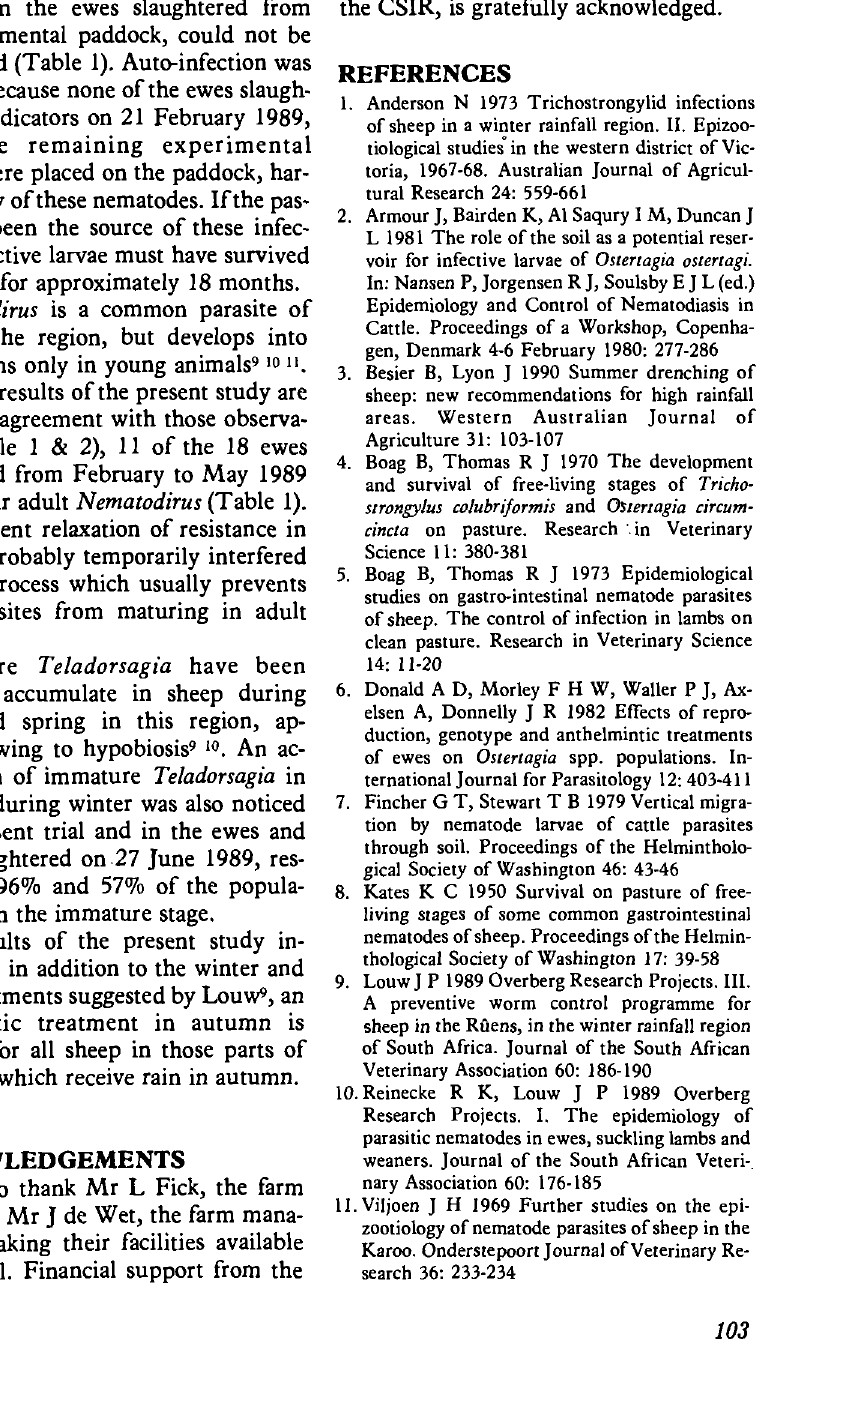
Fig. 2: Geometric means of the worm burdens of groups of ewes and lamb